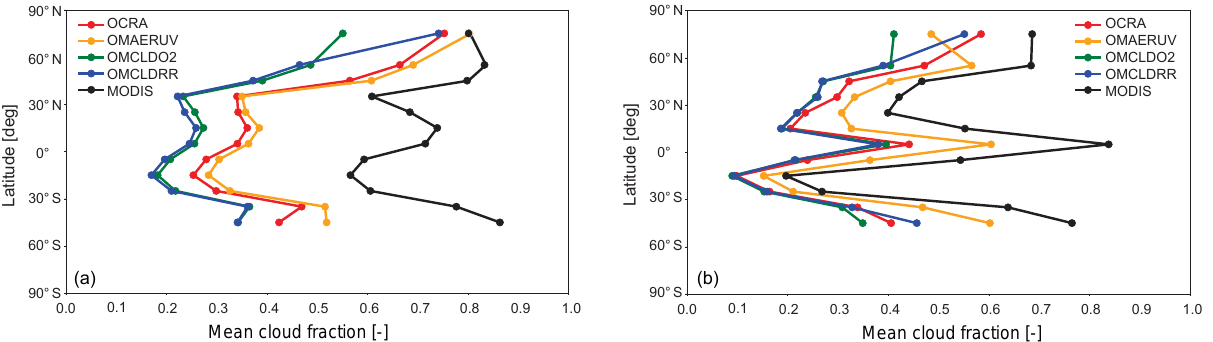
Figure 11. Comparison of cloud fraction zonal means for results from the four OMI algorithms as seen in Fig. 10 and from the MODIS measurements regridded to the corresponding OMI ground pixels. The left panel shows only measurements over ocean, while the right panel shows only measurements over